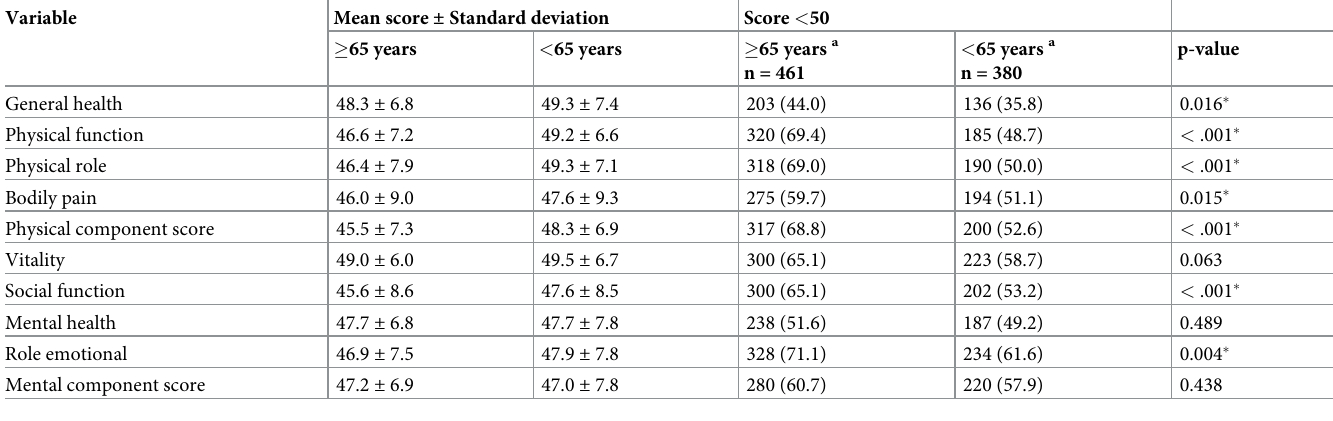
Table 2. Quality of